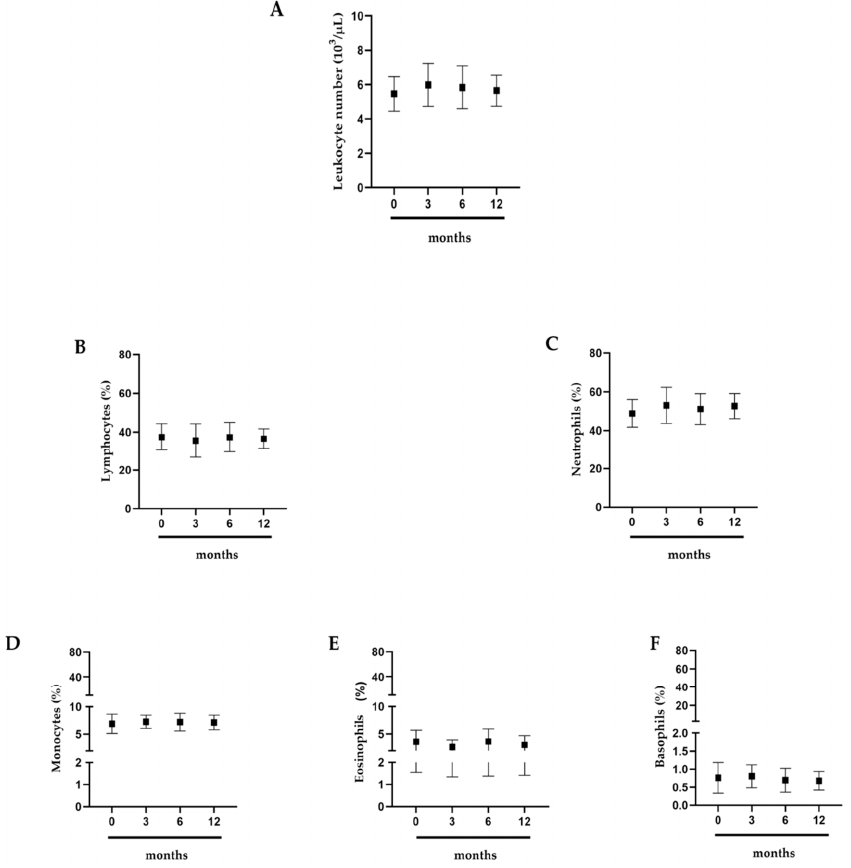
Figure 2. White blood cells. ( A ) Leukocytes; ( B ) lymphocytes; ( C ) neutrophils; ( D ) monocytes; ( E ) eosinophils; ( F ) basophils. Assessment of 15 professional basketball athletes at 0, 3, 6, and 12 months.